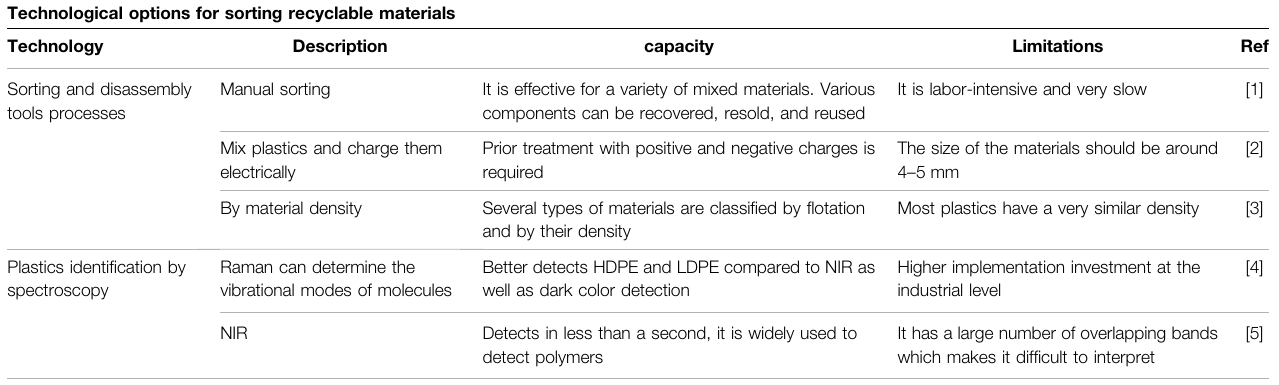
TABLE 4 | Summary of the existing methods and technological options in the management of post-consumer plastic